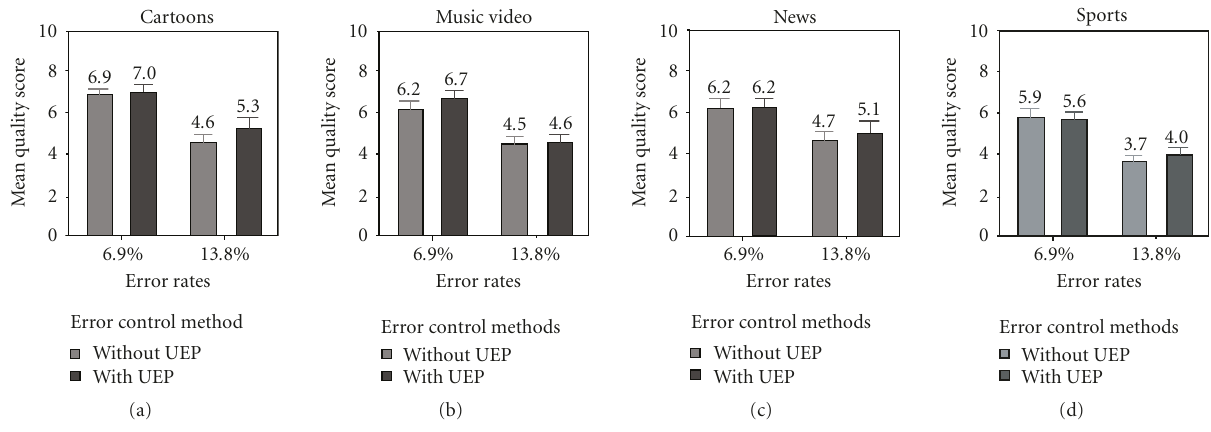
Figure 11: Per-sequence satisfaction ratings for UEP scheme. The error bars show 95% CI of mean.